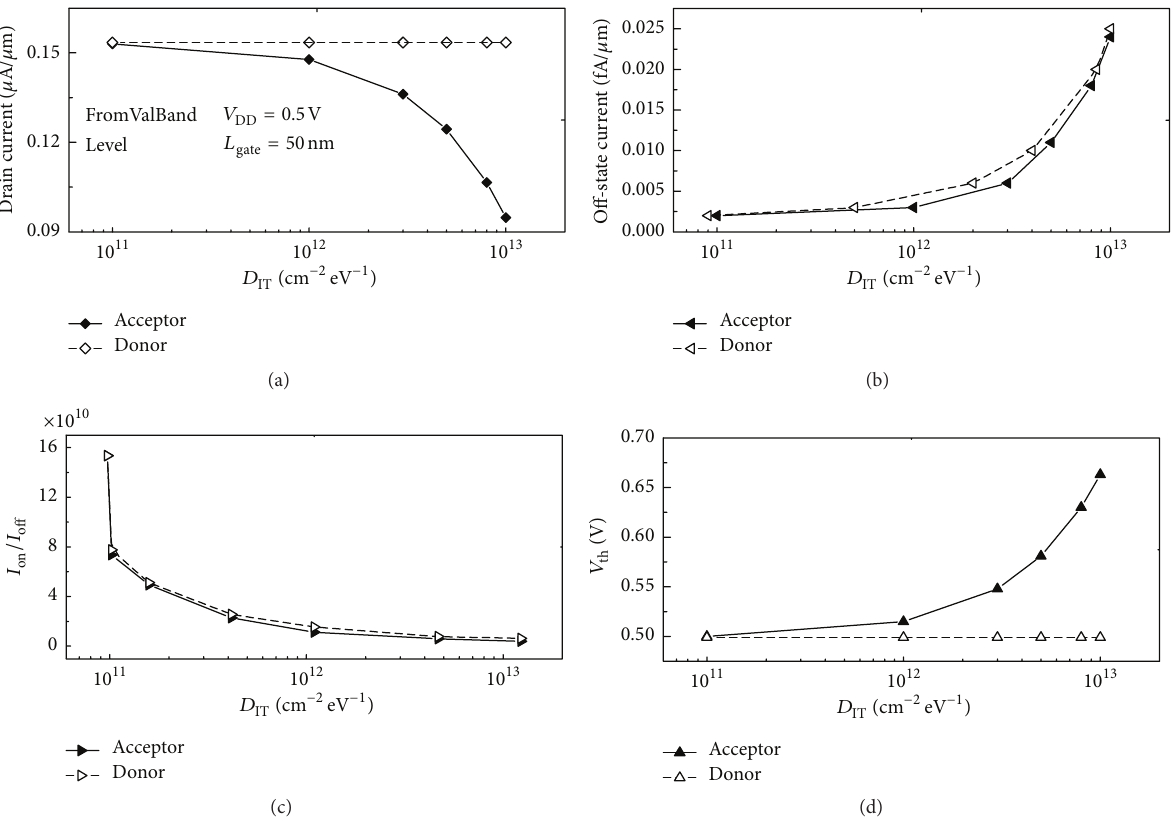
= 𝑉 = 0.5 V, (b) off-state 𝐼 at 𝑉 on GS DS